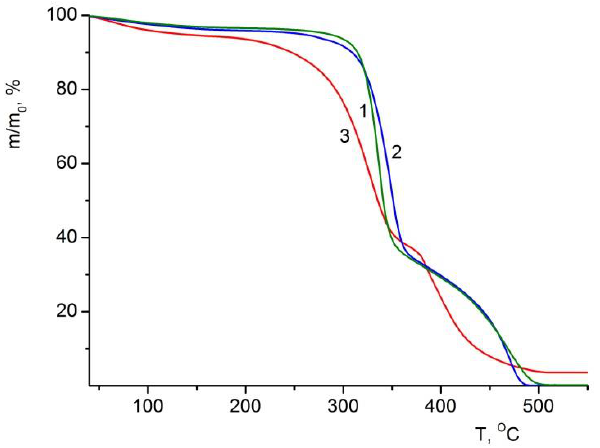
Table 3. Thermal stability indices of BC, BC – ALG – CS, and BC – ALG(CeONP) – CS films in air at- mosphere.